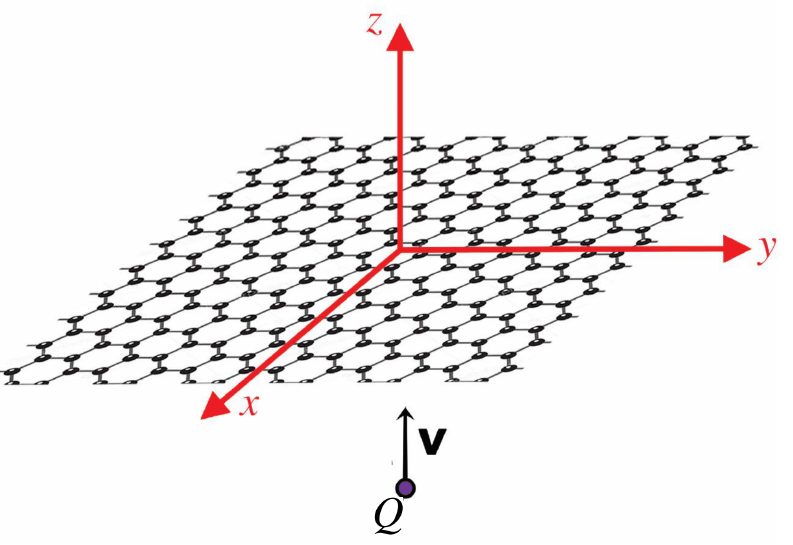
Figure 1. Schematic showing the situation we consider in this work, with the point charge Q approaching the graphene sheet on a normal trajectory (which we take to be along the z -axis) at constant velocity v